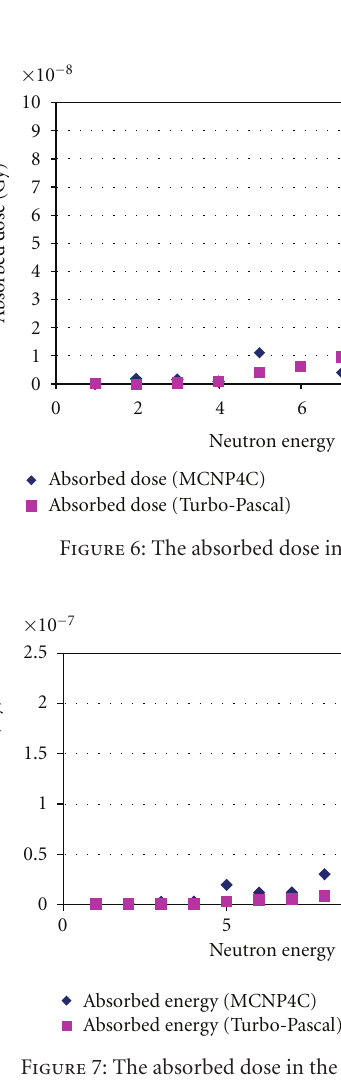
Figure 5: The collision of emitted neutron from the external source to the polyethylene shell.